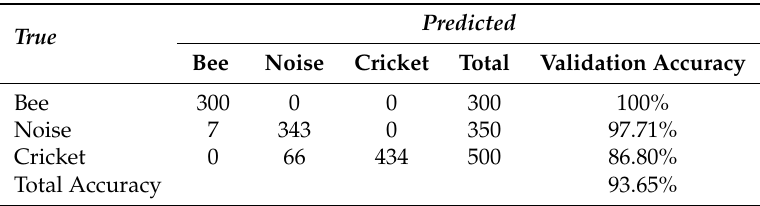
Table A5. Confusion matrix for RawConvNet with receptive field size n = 100 on BUZZ1 validation dataset.